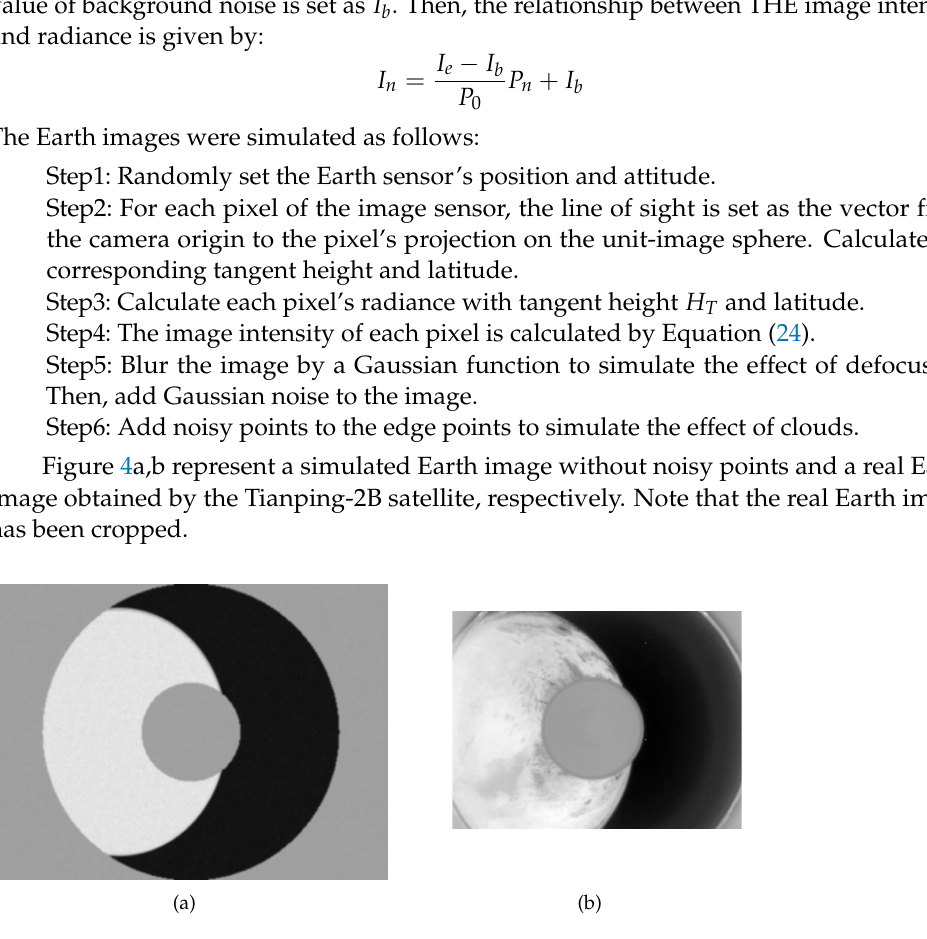
Figure 4. ( a ) Simulated Earth image without noisy points; and ( b ) Real Earth